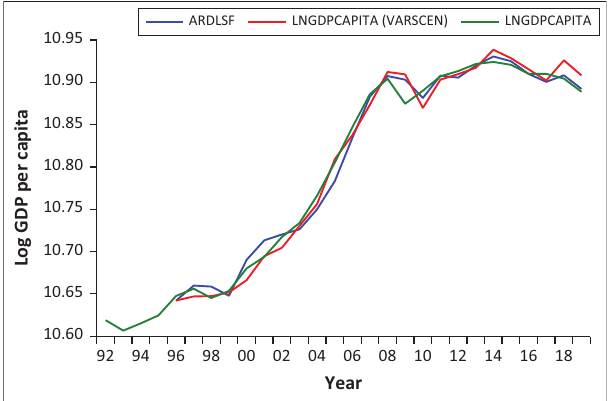
FIGURE 11: Actual versus static forecast using the vector error correction model and autoregressive distributed lag model.